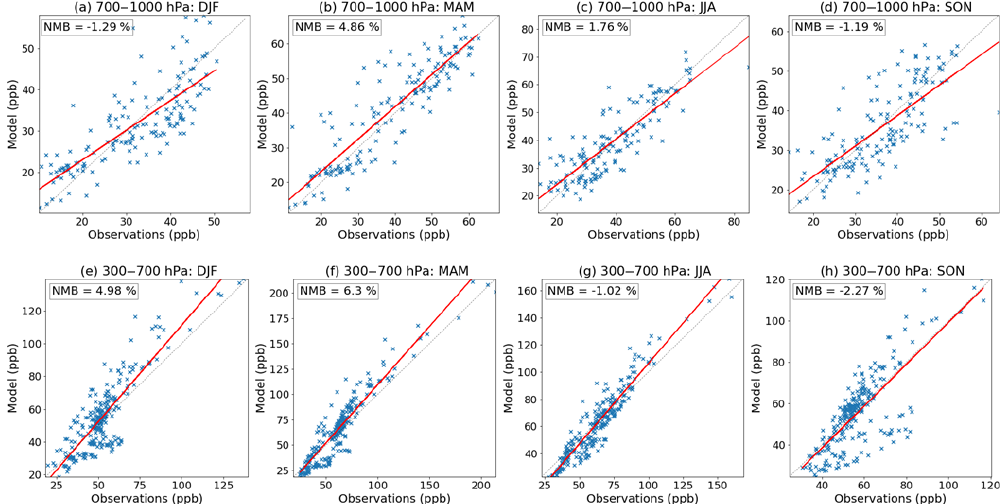
Figure 1. Comparison of seasonal mean simulated O 3 concentrations (ppb) against mean ozone-sonde observations from Tilmes et al. (2012), for the period 1995–2011. Panels (a–d) show mean concentrations at 700–1000hPa across all sites, while panels (e–h) show mean concen- trations at 300–700hPa. Values in each panel are seasonal means in (from left to right) December–February (DJF), March–May (MAM), June–August (JJA) and September–November (SON). The red line represents the linear regression. Normalized mean bias (NMB) values between the model and observations are also shown. Table 2. Present day (2000) TOMCAT model diagnostics compared to previous model version from Monks et al. (2017) and other published values. Diagnostic TOMCAT Monks et Other Reference (this study) al. (2017) estimates 342 331 337 ± 23 Young et al. (2013) Tropospheric OH concentration 1.04